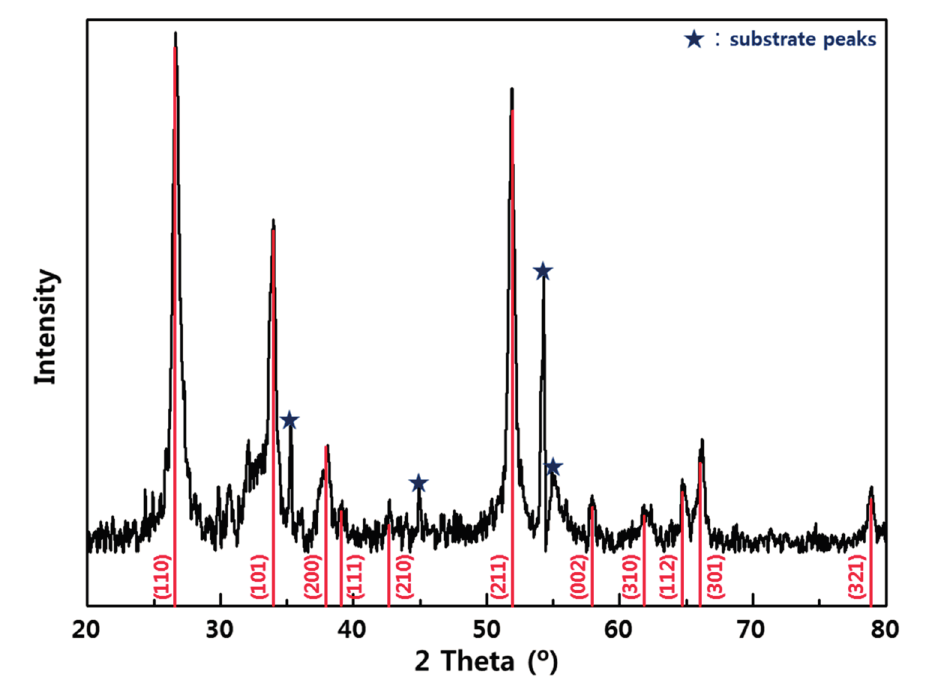
Figure 2. X-ray diffraction pattern of the SnO 2 thin